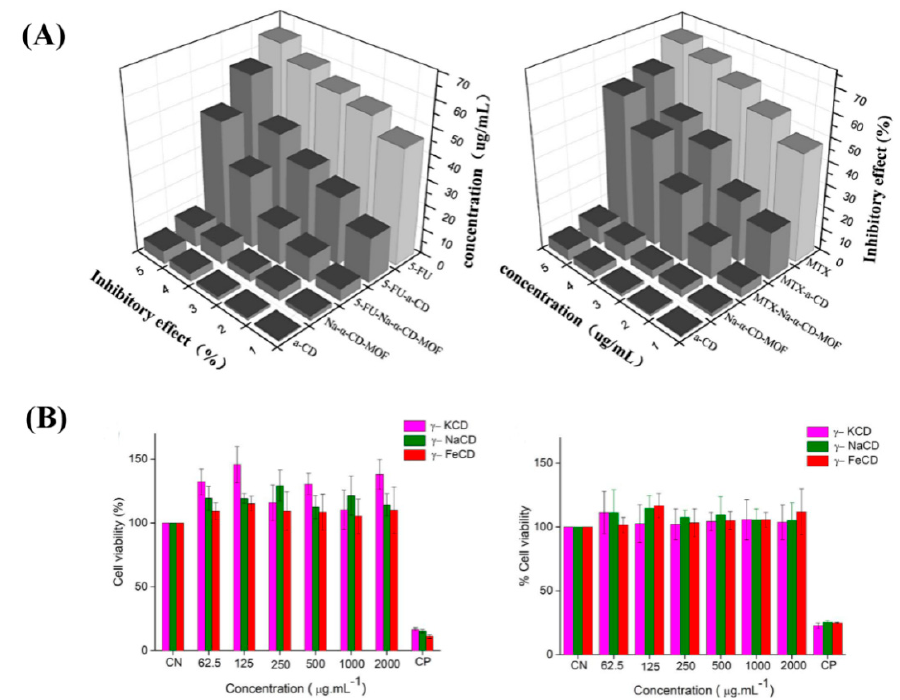
Figure 5. ( A ) Chart of cytotoxicity on HepG2 cells for α -CD, Na- α -CD-MOF, 5-FU (left), MTX (right), 5-FU- α -CD (left), MTX- α -CD (right), 5-FU-Na- α -CD-MOF (left), and MTX-Na- α -CDMOF (right). ( B ) Cytotoxic effect of three γ -CD-MOFs at a concentration of 62.5–2000 µg/mL: (left) HepG2 cell lines and (right) Caco-2 cell lines. Reprinted with permission from [58,69], copyright Elsevier, 2018 and Elsevier, 2017.